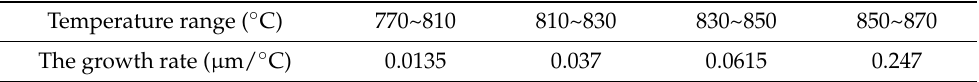
Table 3. Austenite grain sizes and grades of the steel at different heating temperatures of Q